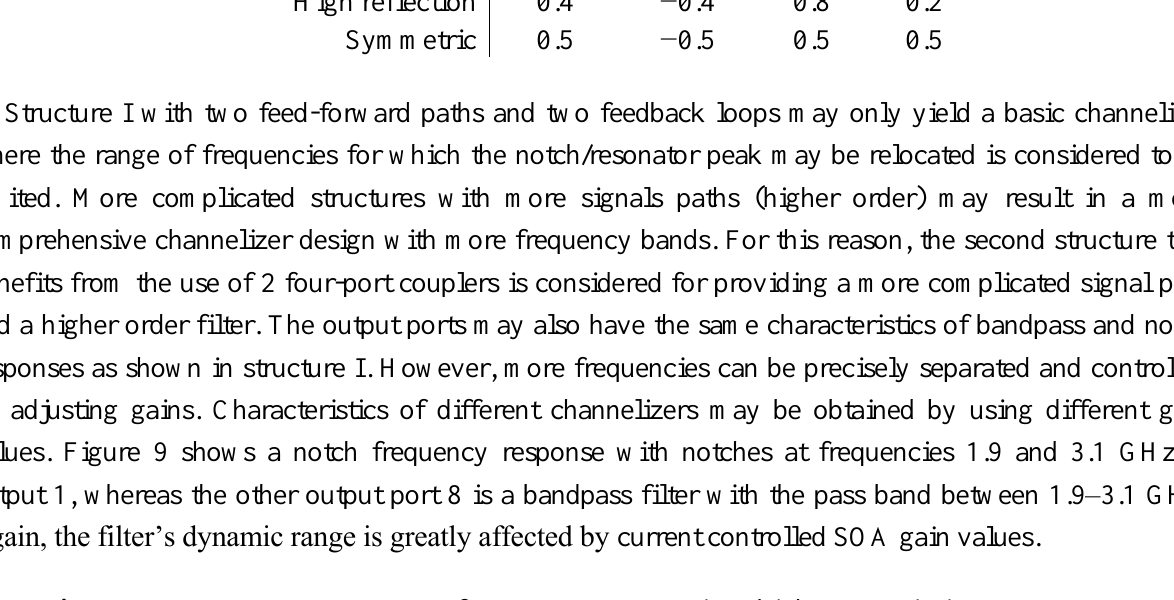
Figure 9. Frequency response for structure II using high transmission parameters. Different notch locations are